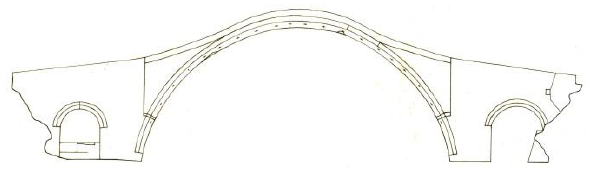
Figure 2. Plaka bridge South Façade plan (1984).